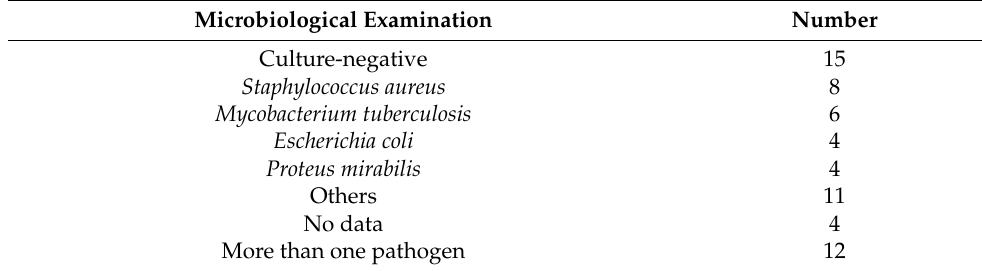
Table 1. Microbiological examination among pediatric ISCA patients.